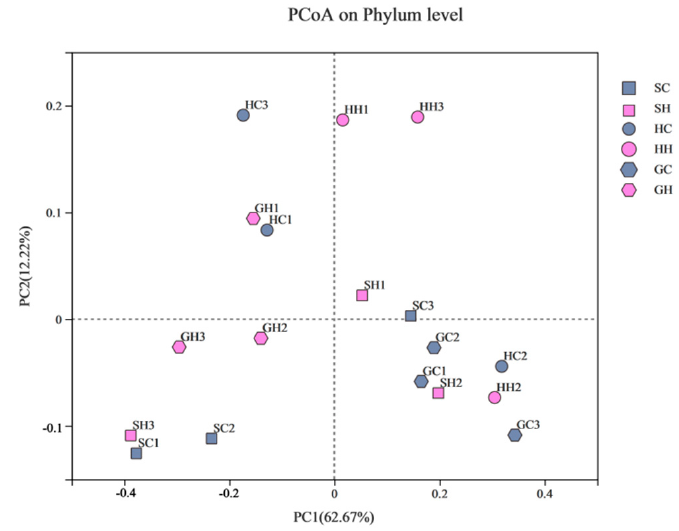
Figure 5. Principal co-ordinates analysis (PCoA) of fungal communities at the phylum level for all samples. Note: Alkaline soils are represented by triangles; neutral soil samples are represented by squares; acid soil samples are represented by circles, mercury treatments are filled in pink; control treatments are filled in green.